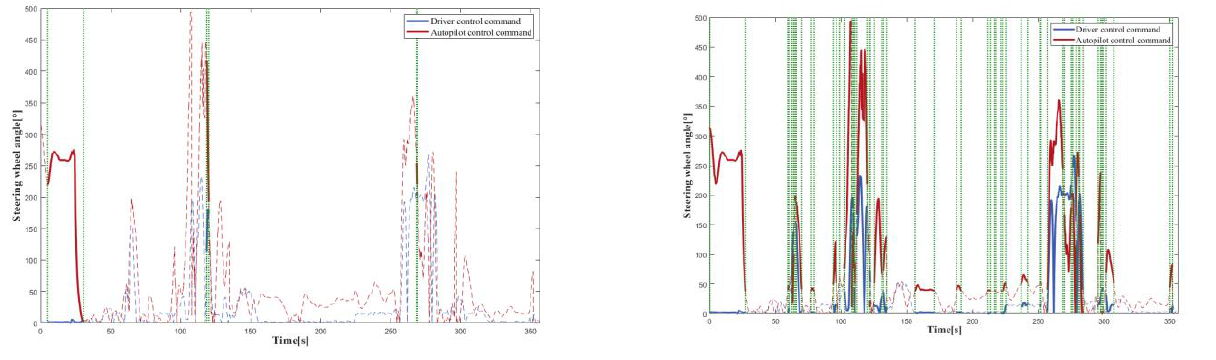
Figure 13. The 1st round test results for lateral control command discrepancy data trigger recording.